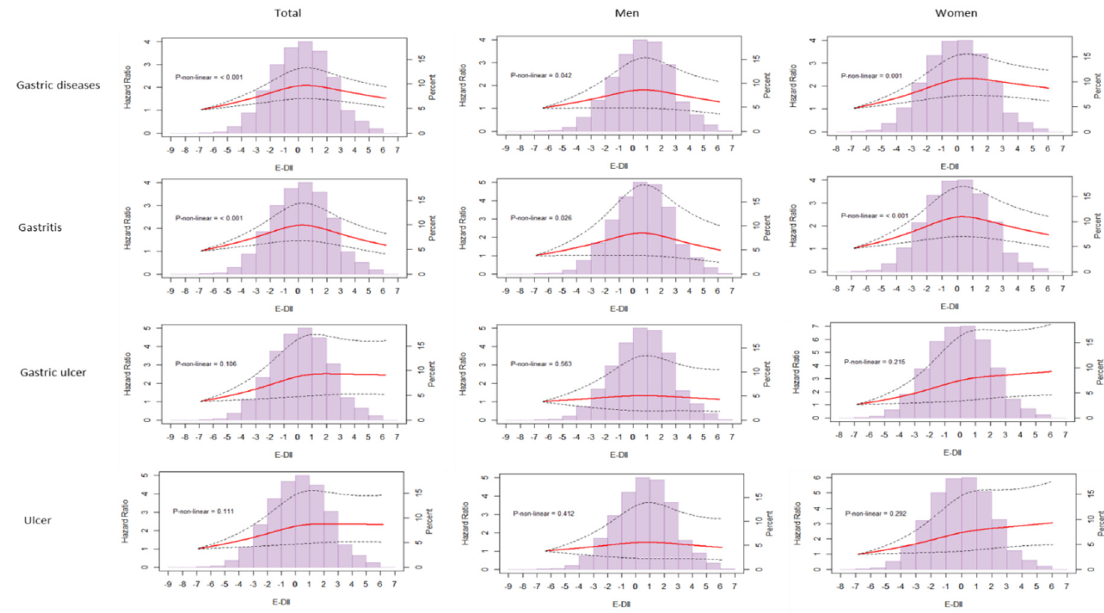
Figure 3. Dose-response analysis of the KoGES_HEXA using spline regression for the association between E-DII and gastric disease risk among the total population, men, and women. Solid lines illustrate point estimates and dashed lines represent 95% confidence intervals. Hazard ratios were calculated by the model adjusted for sex, age, education, smoking, drinking, physical activity, and BMI. The histograms show the distribution of E-DII levels in each corresponding group.